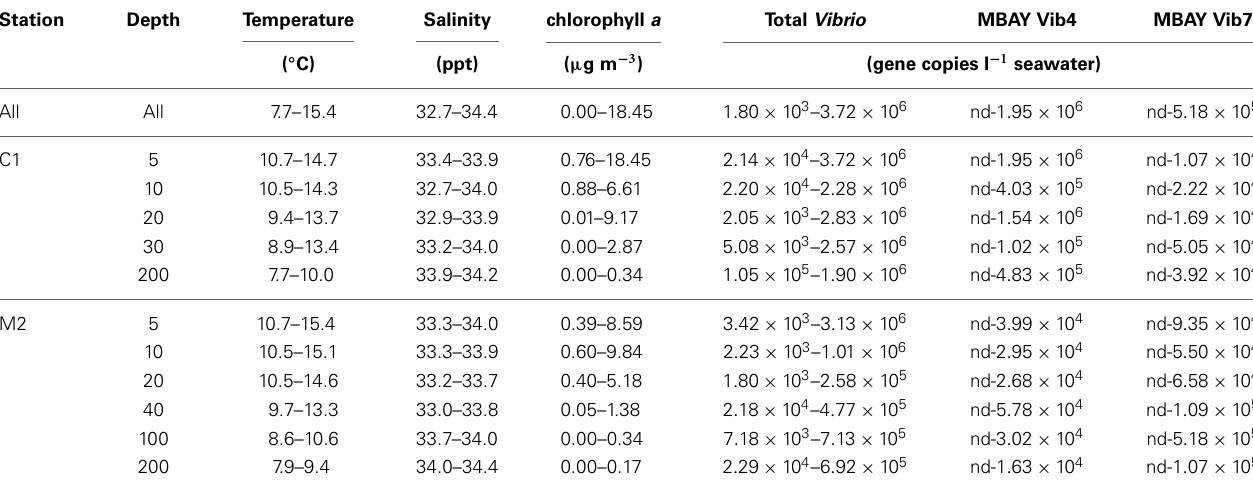
Table 2 | CTD measurement and Vibrio concentration ranges over the study period for all stations and depths.